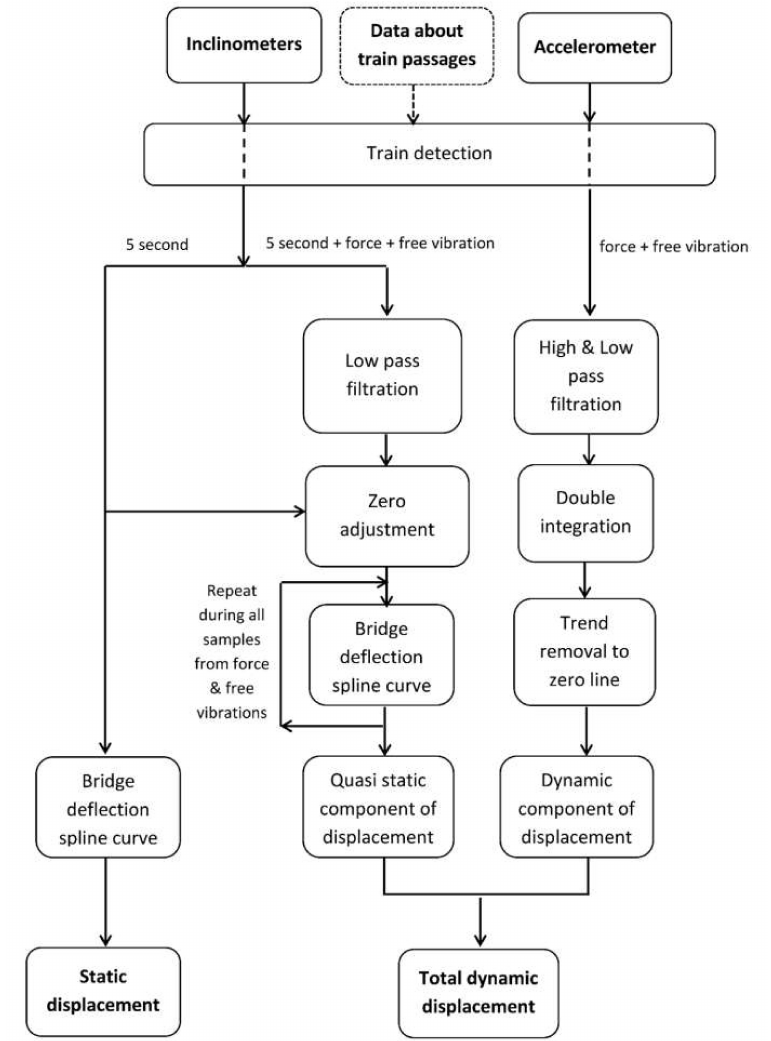
Figure 1. A flow chart of the static and dynamic displacement monitoring: The left path of the static displacement determination, the central path of the quasi static component, and the right path of the dynamic component of dynamic displacement